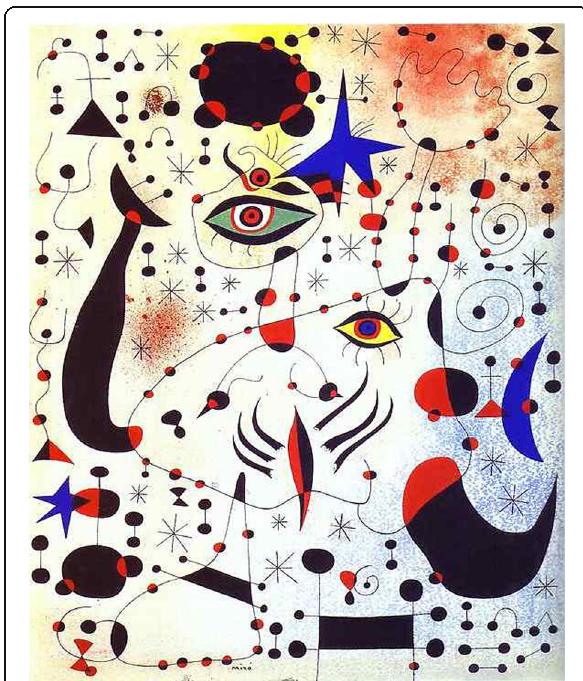
Fig. 18 Miro ’ s “ Ciphers and Constellations in Love with a Woman ”